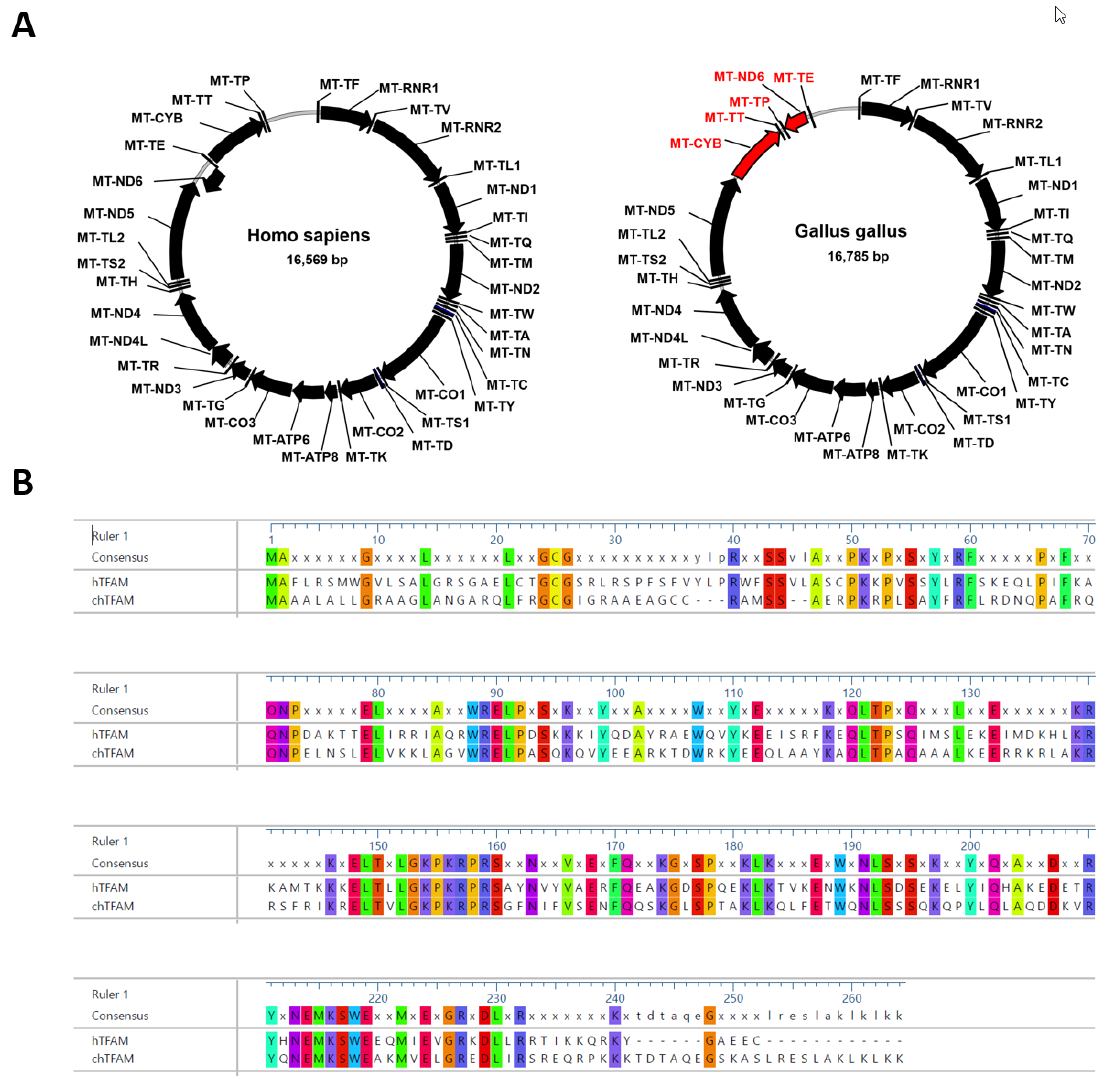
Figure 2. Maps of human and chicken mitochondrial genomes and alignment of corresponding TFAMs. ( A ) Organization of human and chicken mtDNA. Positions of 37 mtDNA-encoded genes are indicated. Note the gene order rearrangement at the 5’ end of the control region in chicken mtDNA (red). ( B ) Alignment of human and chicken TFAMs. Identical residues are highlighted. MegalignPro, Lasergene 17 package, MUSCLE algorithm.